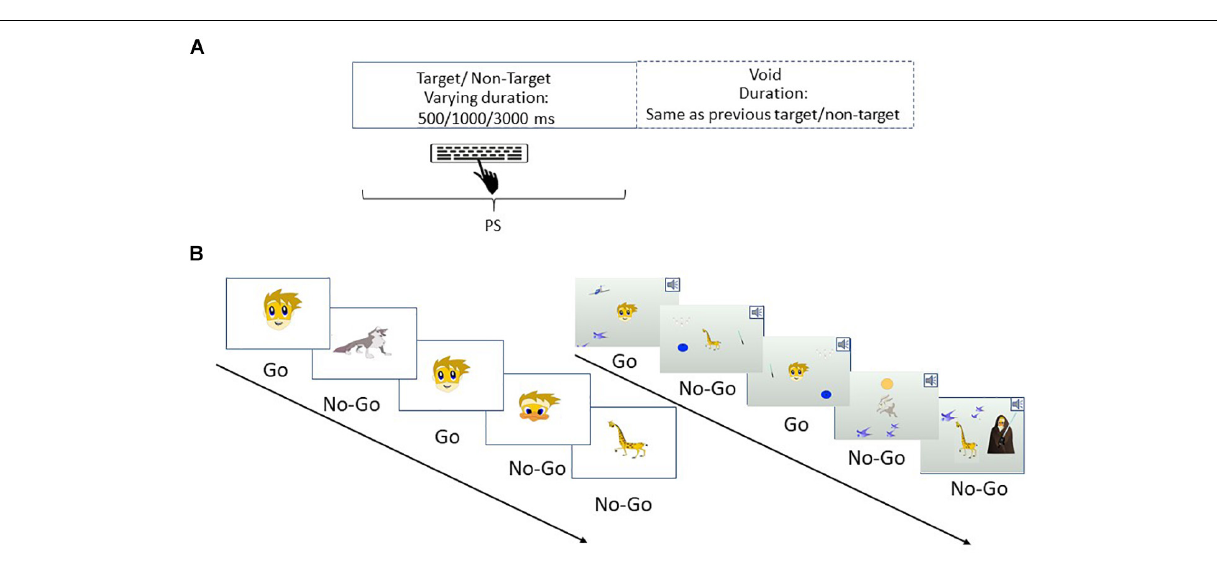
FIGURE 2 | An example of the MOXO-CPT. (A) Stimuli are presented on the screen for varying amounts of time (500, 1000, or 3000 ms) followed by a “ void ” period of time of the same duration. Participants should respond to target stimuli as quickly as possible and withhold response to non-target stimuli. (B) PS was evaluated under several experimental conditions, in which distractor modality (none, visual, auditory, or combined) and distractor load (no load, low load, and high load) were manipulated. Left: an example of a task sequence with no distractors and no load. Right: an example of a task sequence with combined distractors and high load. All rights in the image are reserved to Neurotech Solutions